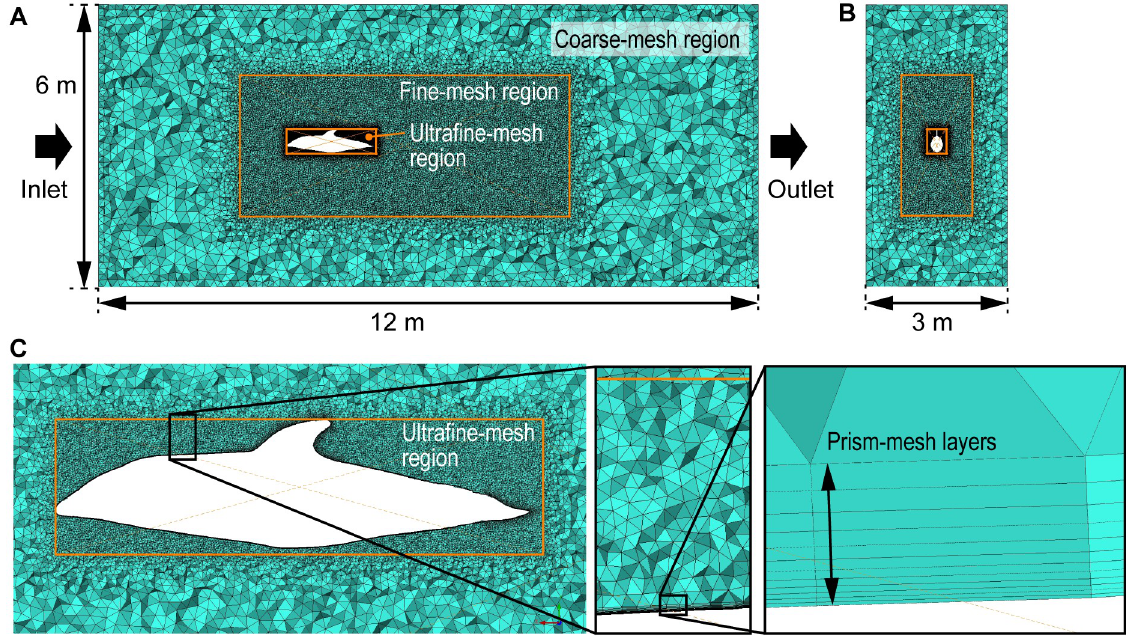
Fig 5. Meshes for CFD simulation. (A) Meshes at the sagittal plane of the whole fluid region. (B) Frontal cross section of the fluid region at the mid body. (C) Close-up of the meshes at the sagittal plane near the body surface.